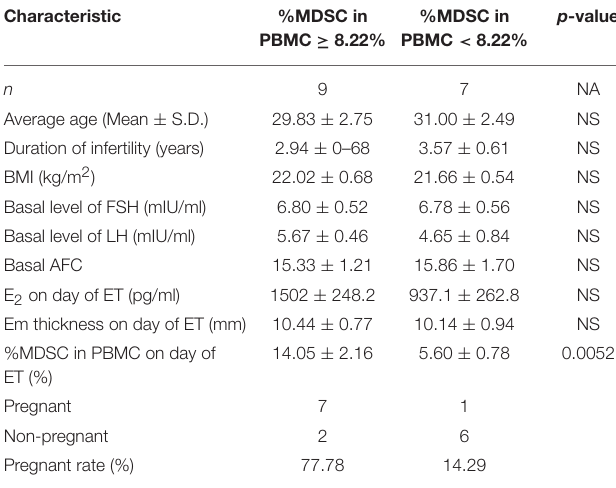
TABLE 3 | Clinical and outcome of IVF